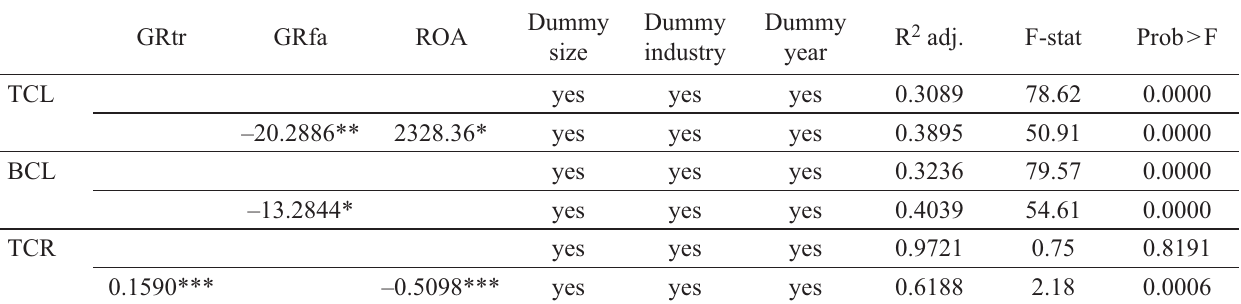
Table 6. Fixed effects models for the dependence of costs on the growth rate and control variables GRtr GRfa